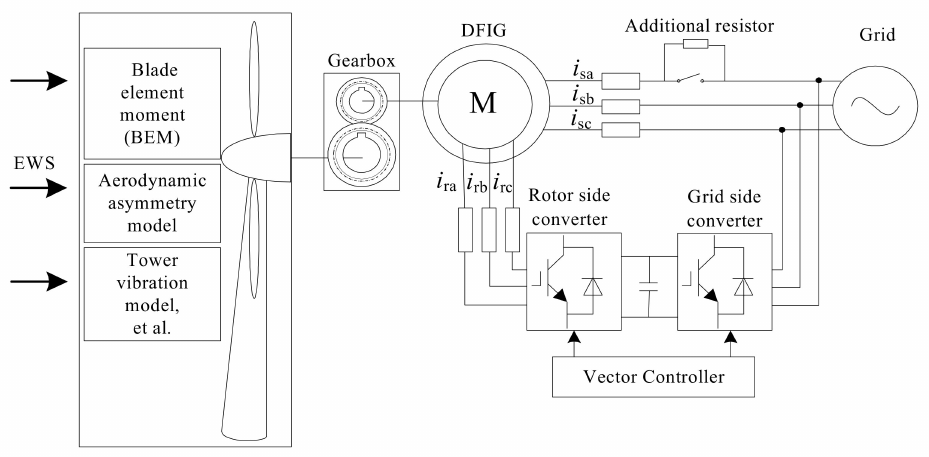
Figure 4. Simulation